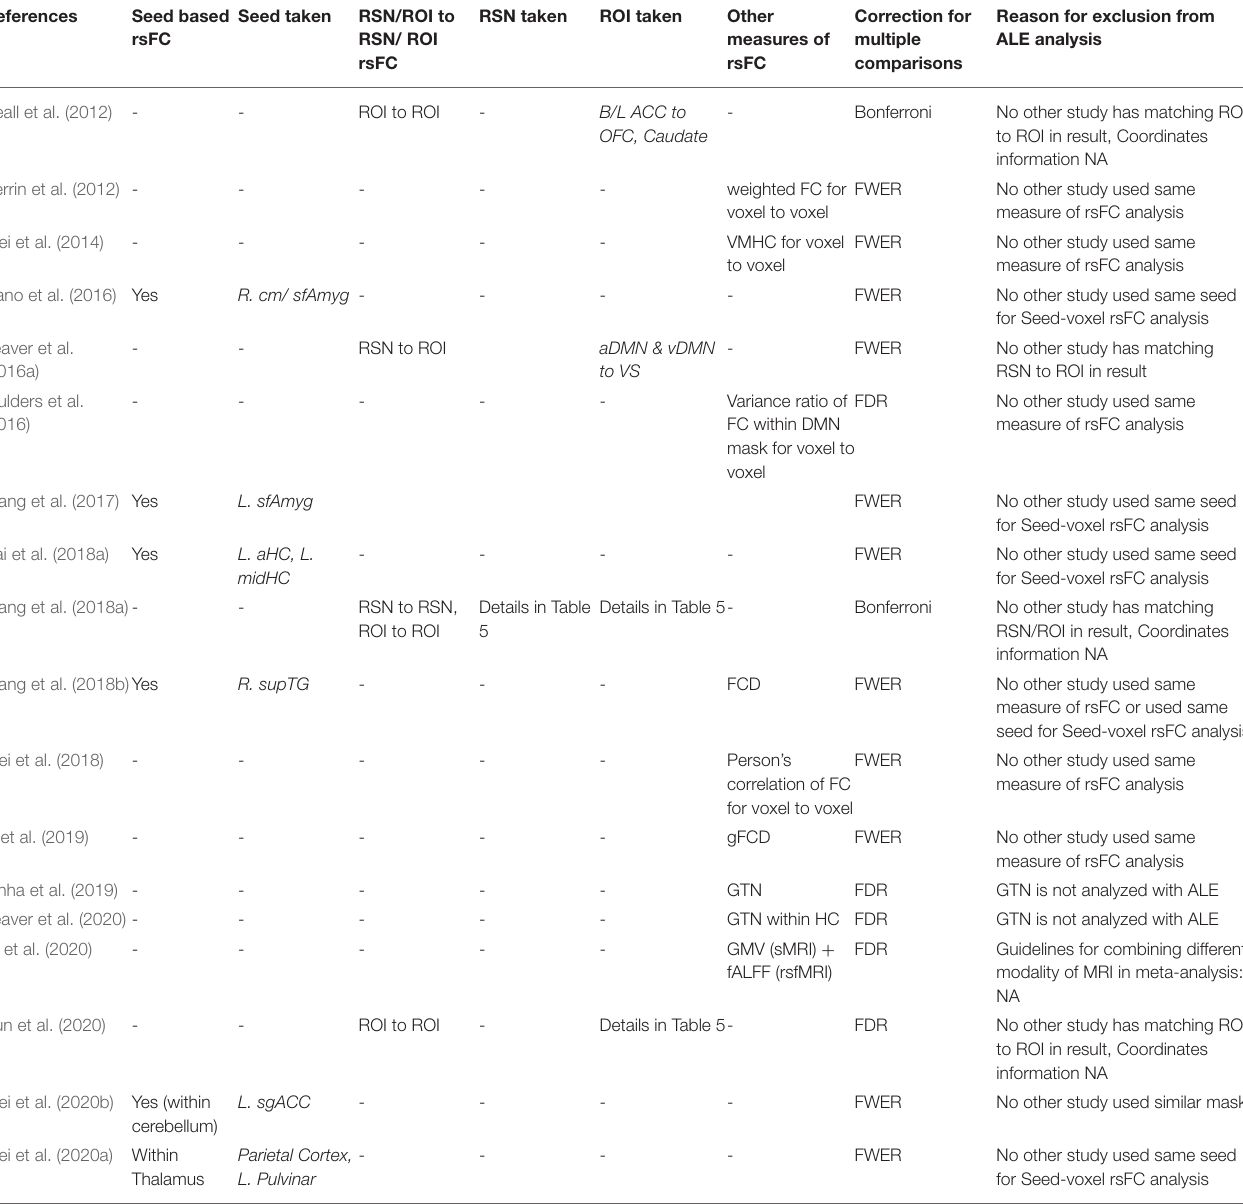
TABLE 2 | List of studies with their different measures of rsFC excluded from ALE analysis examining the effect of ECT in depression and the reasons for exclusion.